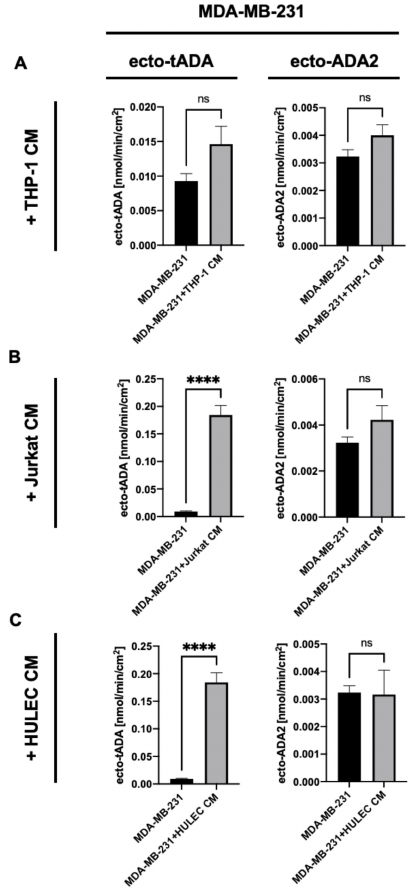
Figure 1. Total cell surface adenosine deamination rate (ecto-tADA) and ADA2 related cell surface adenosine deamination rate (in the presence of ADA1 inhibitor, EHNA) on human triple negative breast cancer cells (MDA-MB-231 cell line) after 48 h incubation with human monocyte/ macrophages medium (THP-1 CM, A ), Jurkat cell medium (Jurkat CM, B ), and human microvascular lung endothe- lial cell medium (HULEC CM, C ). Results are shown as mean ± SEM, n = 6 − 9, **** p < 0.0001 by unpaired t